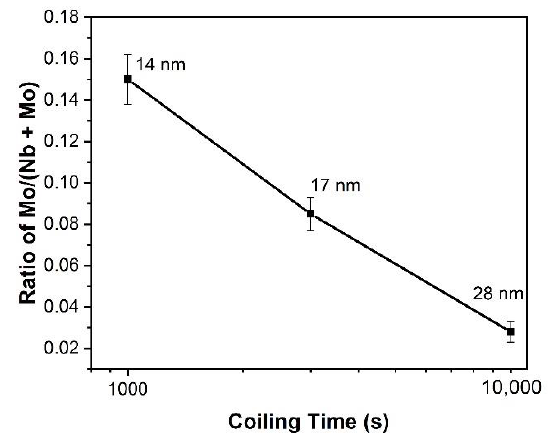
Figure 8. Mo / (Nb + Mo) ratio of carbides formed in the Nb-Mo steel heat treated at 900 ◦ C for Figure 8. Mo/(Nb + Mo) ratio of carbides formed in the Nb-Mo steel heat treated at 900 °C for various various times.